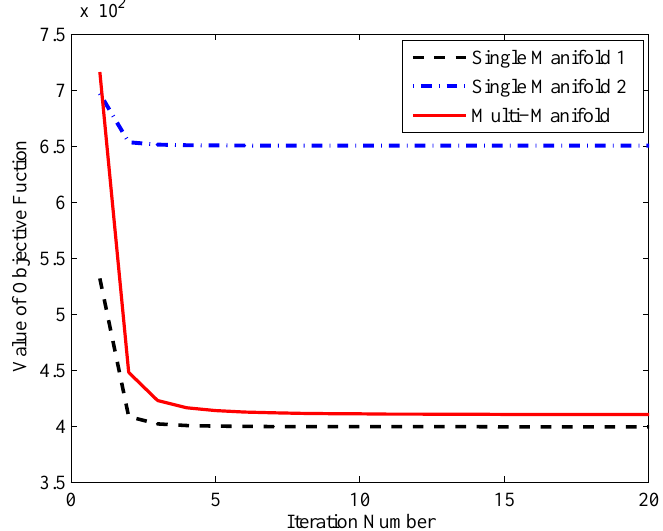
Figure 6. The convergence cure of different regularization. The single manifold 1 and the single manifold 2 denote the methods with pairwise similarity rule and local linearity rule, respectively. The multi-manifold represents the proposed MLA